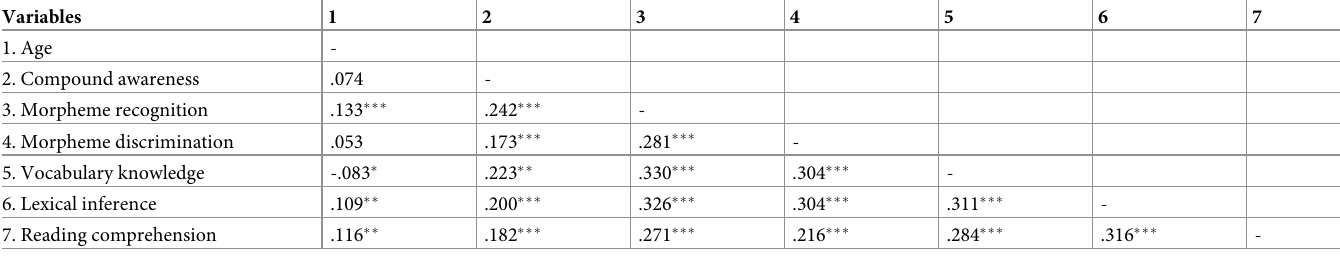
Table 2. Bivariate correlations among morphological awareness, vocabulary, lexical inference and reading comprehension. Variables